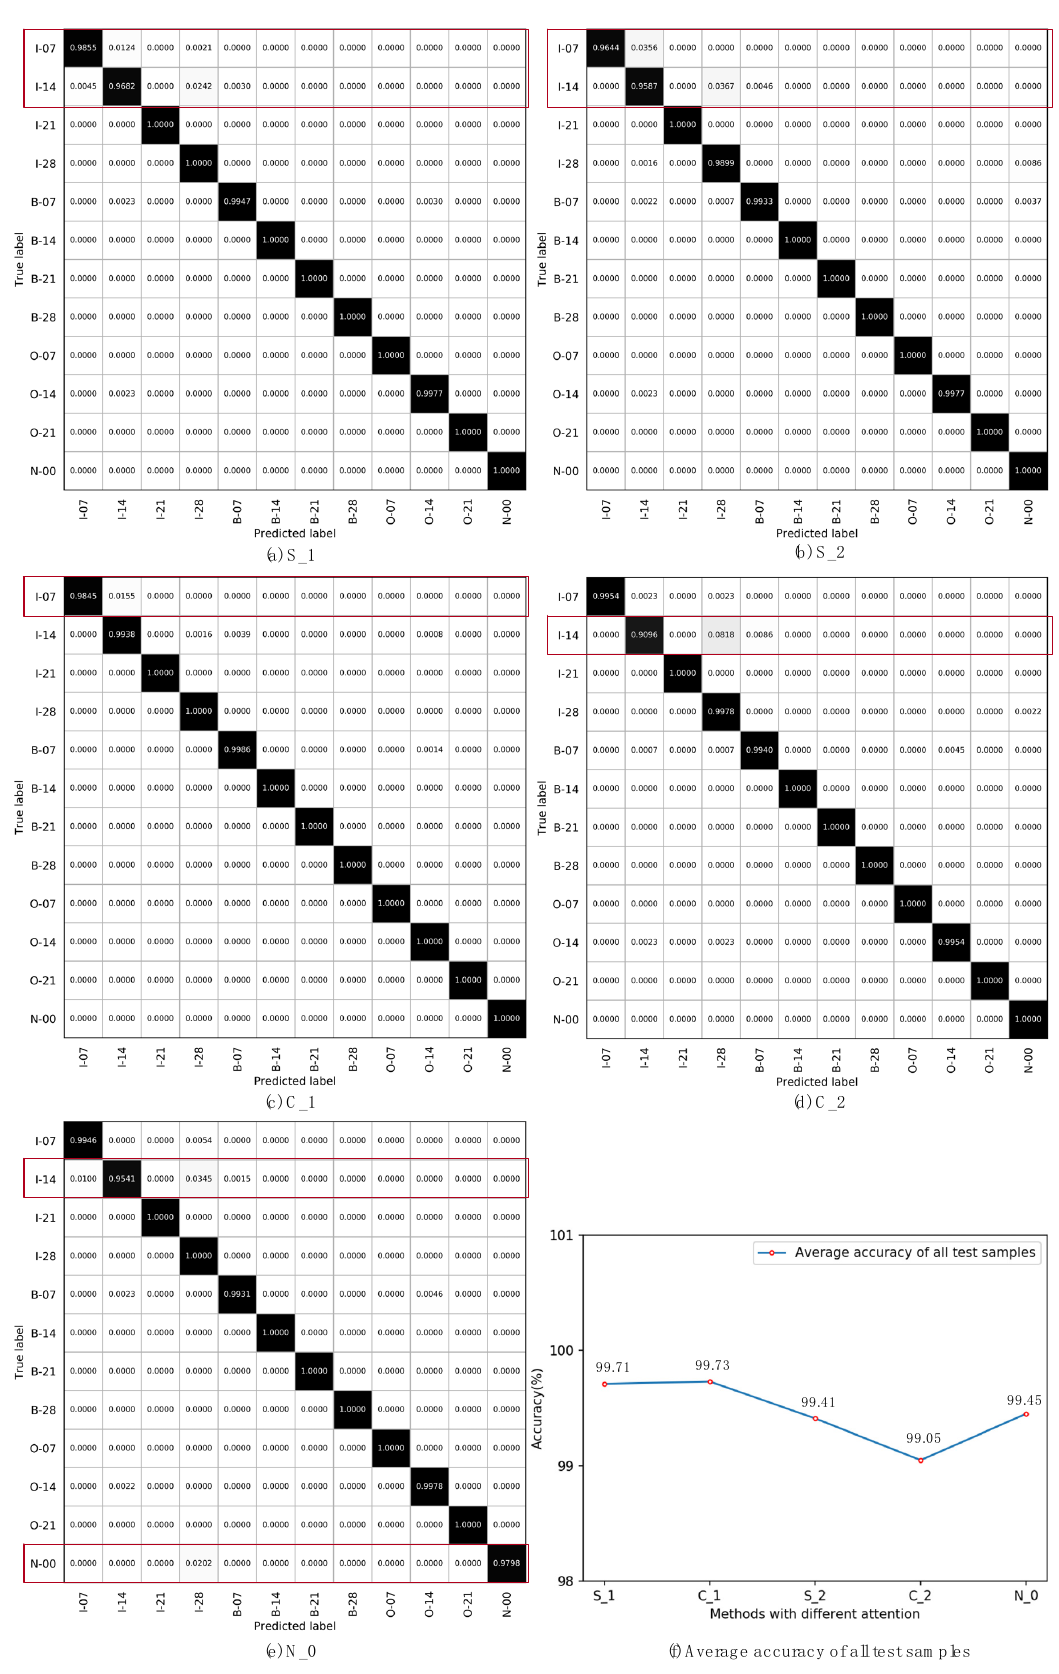
Figure 10. The results of fault identification using the proposed MA-MSCNN with di ff erent kinds of single attention